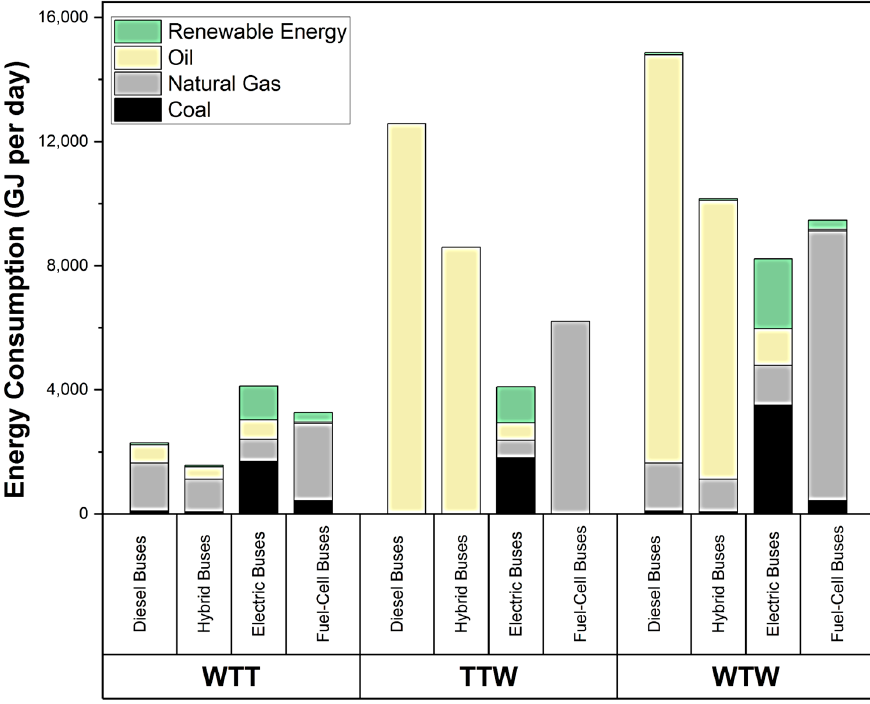
Figure 7. Daily Energy Need of Different Fuel Bus Technologies in Morocco.